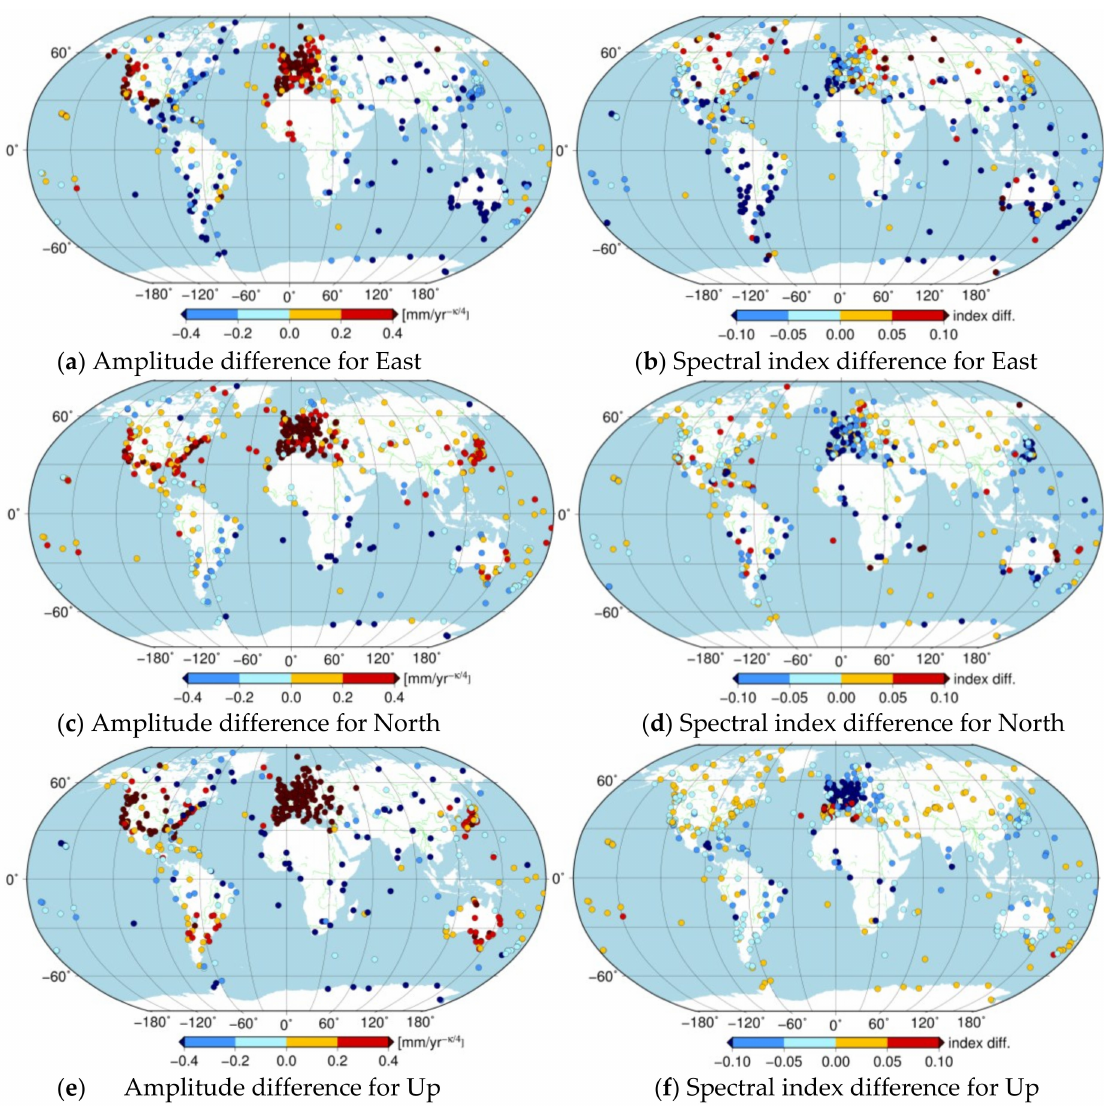
Figure 7. Amplitudes and spectral indexes differences between the solution igs_unit_none and igs_unit_trs for the global distributed